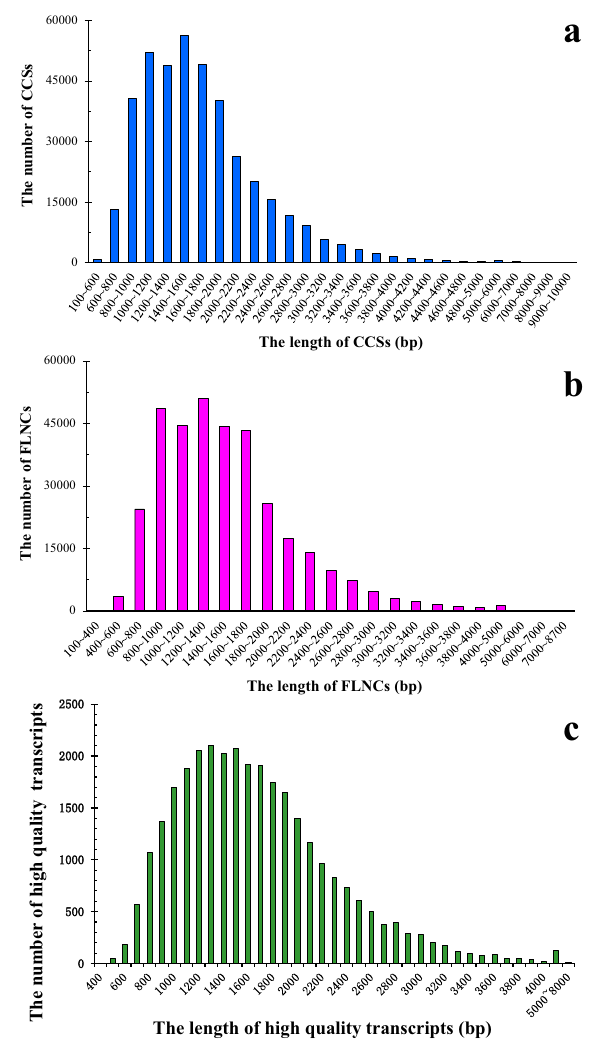
Figure 1. SMRT sequencing of P. catalpifolia leaf transcriptomes. ( a ) Length distribution of CCSs. ( b ) Length distribution of FLNCs. ( c ) Length distribution of high-quality transcripts. Figure was made by Microsoft Office Excel 2013 software.